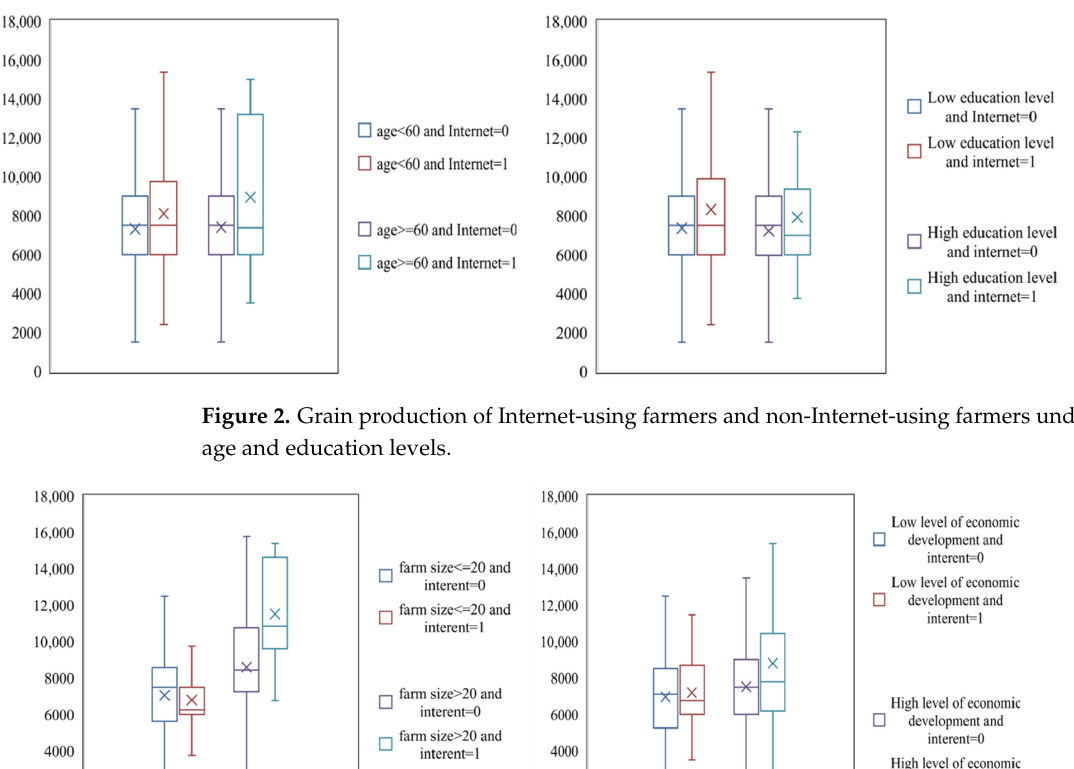
Figure 1. The difference in food production between Internet-using farmers and non-Internet-using farmers .